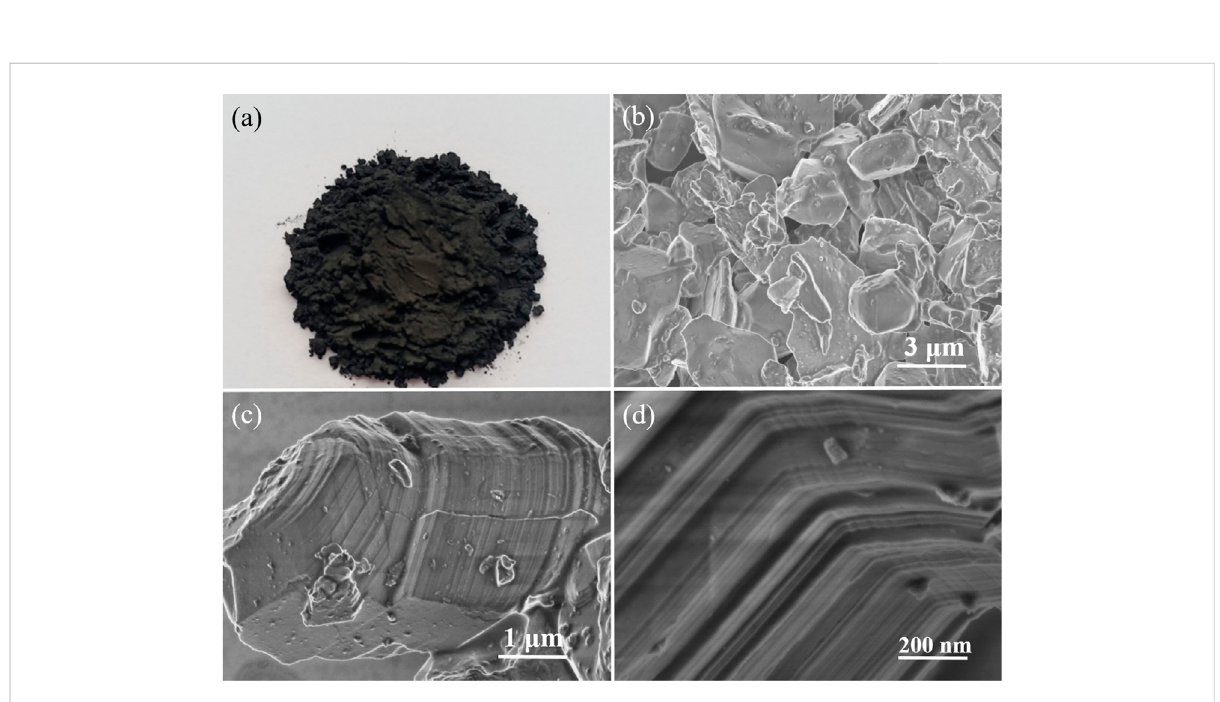
FIGURE 2 Digital photograph of the Ti 3 AlC 2 powders (A) , SEM images of the Ti 3 AlC 2 powders with different magni fi cations (B – C) , and magni fi ed section SEM image of individual particle of Ti 3 AlC 2 powders (D)